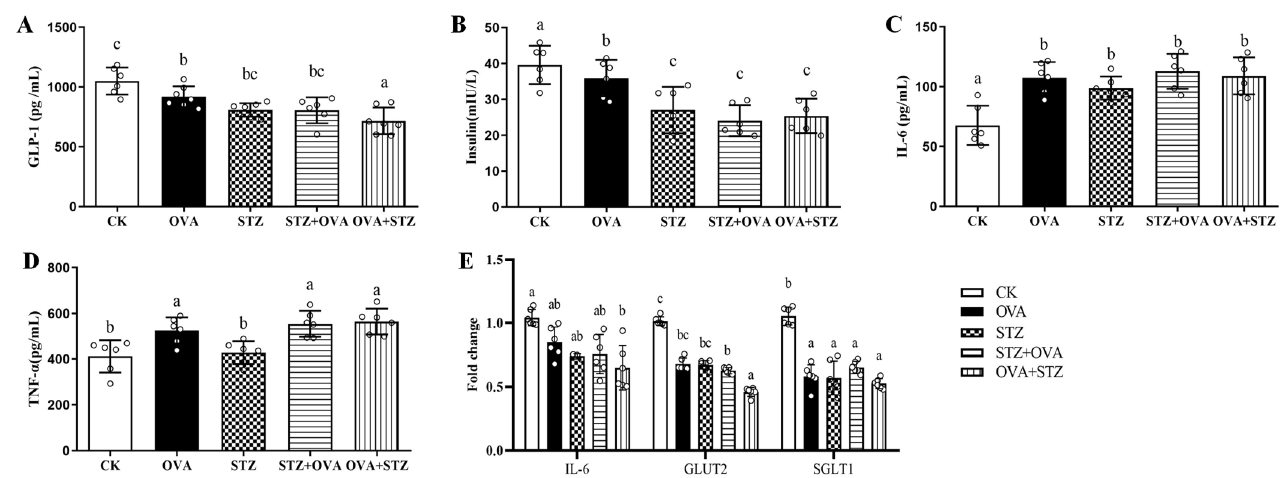
Figure 6. Food allergy affects diabetes by demoting the secretion of GLP-1. ( A ), Serum levels of GLP-1. ( B ), Serum levels of insulin. ( C ), Serum levels of IL-6. ( D ), Serum levels of TNF- α . ( E ), mRNA expression of IL-6, GLUT2, and SGLT1 in jejunum. The error bars indicated the mean ± SEM. n = 6. Different lowercase letters in the figure represent significant differences between the groups ( p < 0.05 by one-way ANOVA followed by SNK).